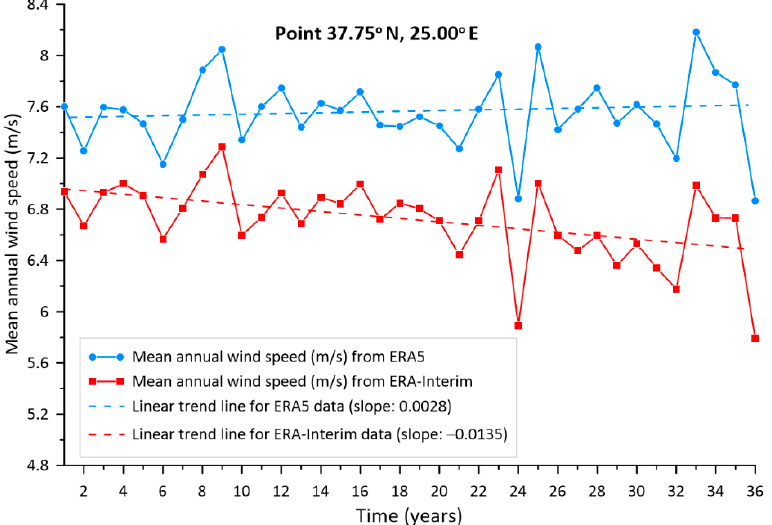
Figure 10. Linear slope of the mean annual wind speed for the location 37.75° N. 25.00° E, as obtained from the ERA-Interim and ERA5 datasets.